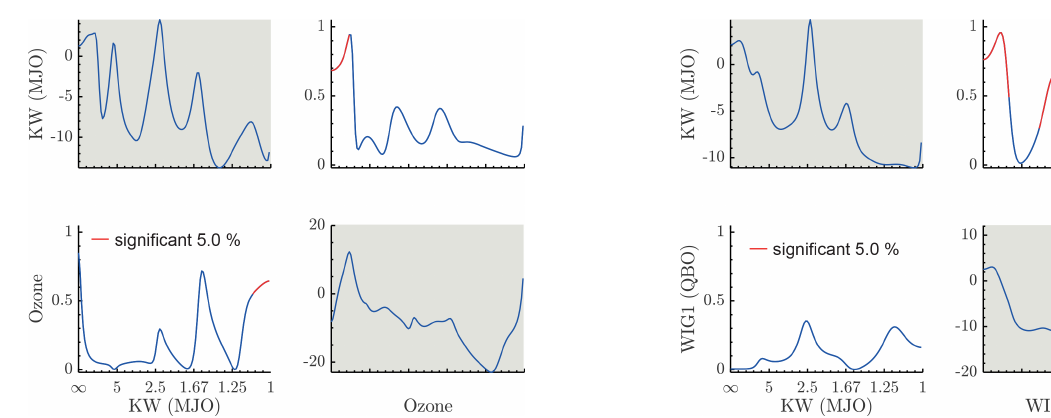
Figure 7. PDC analysis of the interaction of Kelvin modes (KWs) and westward gravity modes (WIGs) at the slow timescale (peri- ods given in years). The results show a strong influence of the WIG mode on KWs on biennial and decadal timescales. Figure conven- tions are the same as in Fig.